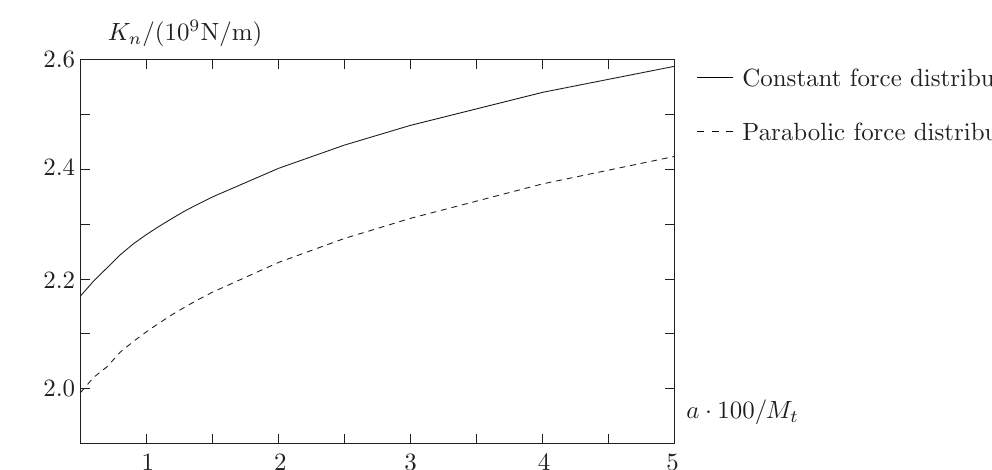
Figure 12: Helical tooth stiffness as a function of contact zone half-width under the assumption of evenly distri- bution of contact load along the contact line. The full line is for the assumption of evenly distribution of contact load along the contact line, the broken line corresponds to the assumption of parabolic force distribution along the contact line.